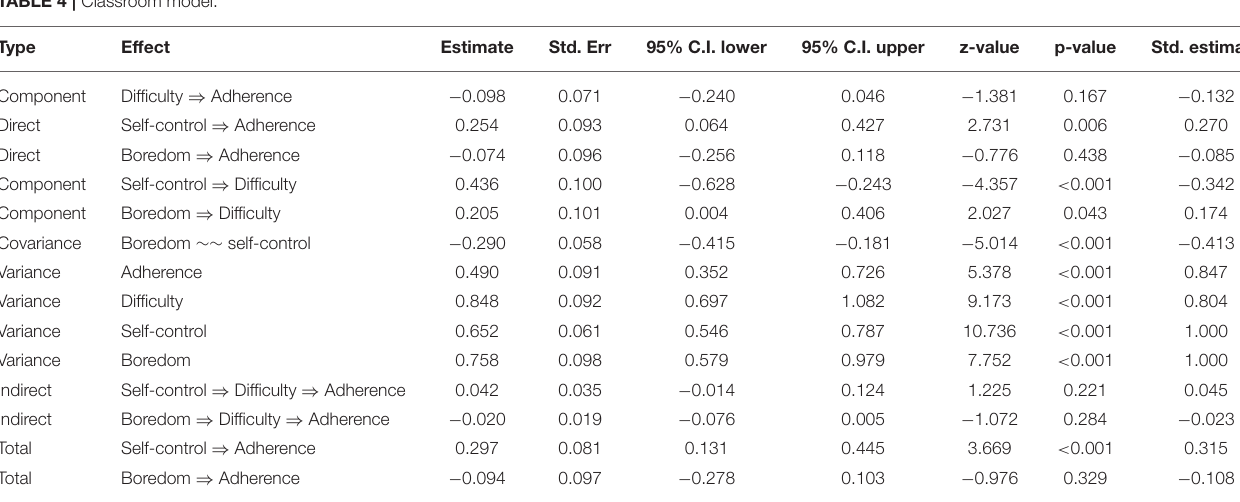
TABLE 4 | Classroom